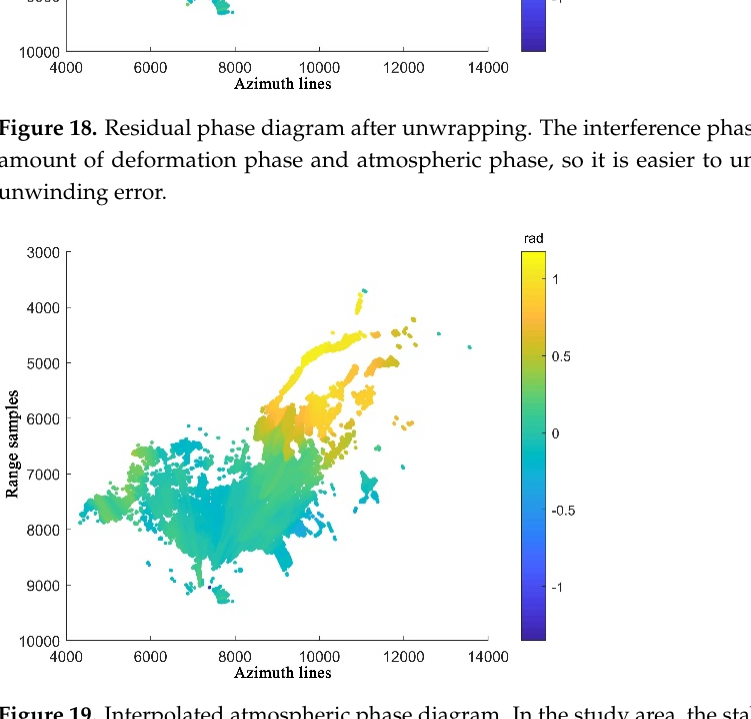
Fig 20 . Residual deformation phase diagram. The residual deformation phase can be calculated by subtracting the interpolated atmospheric phase from the residual.